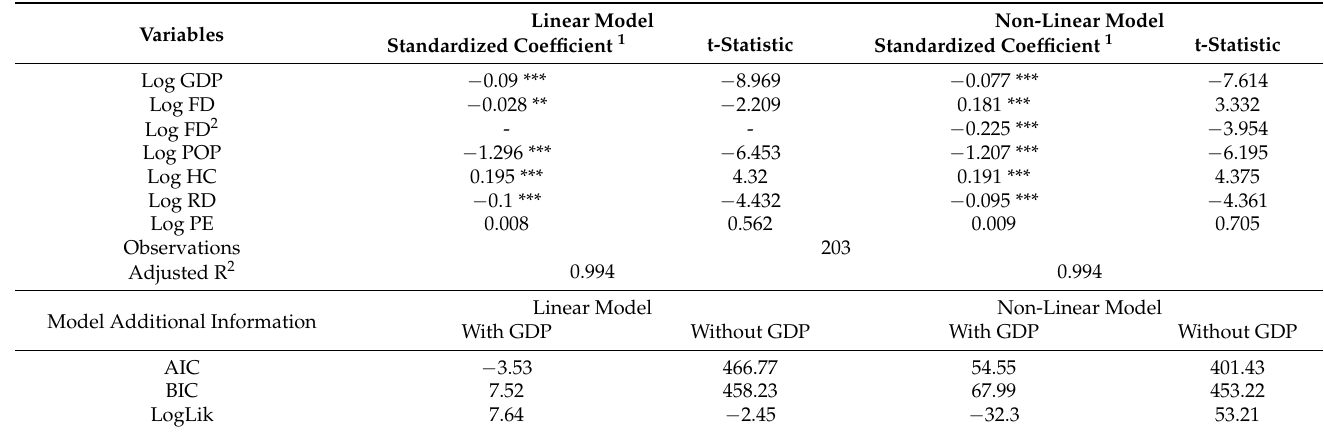
Table 8. Panel data-fixed effect regression results. Dependent variable: MET.